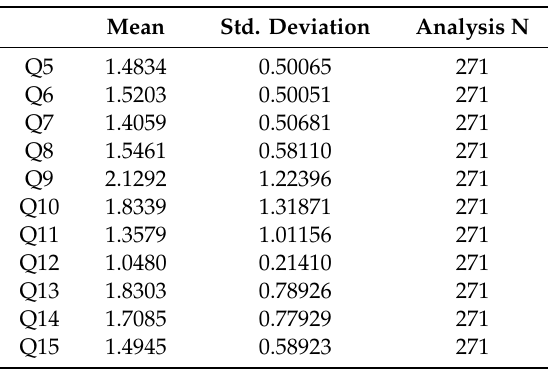
Table 5. Descriptive statistics.